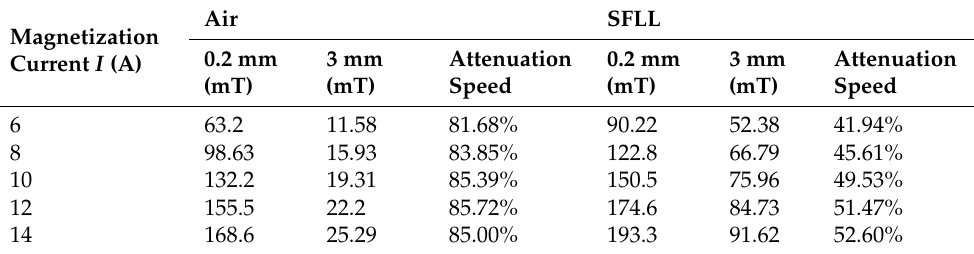
Table 4. Comparison of amplitudes of the MFL signals and attenuation speed of slotted iron plate and air lift-off layer under different magnetization current I when the thickness of lift-off layer varies from 0.25 mm to 3